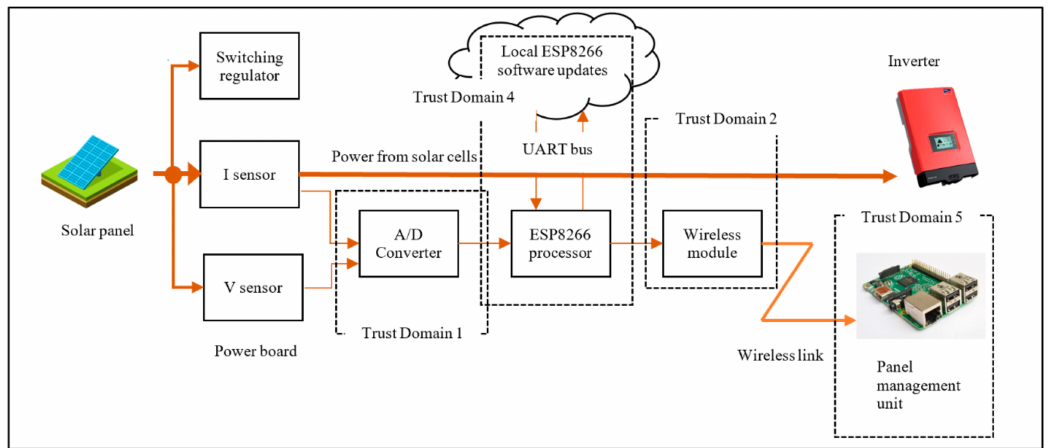
Figure 9. Daedalus Trust Domains without the thin secure